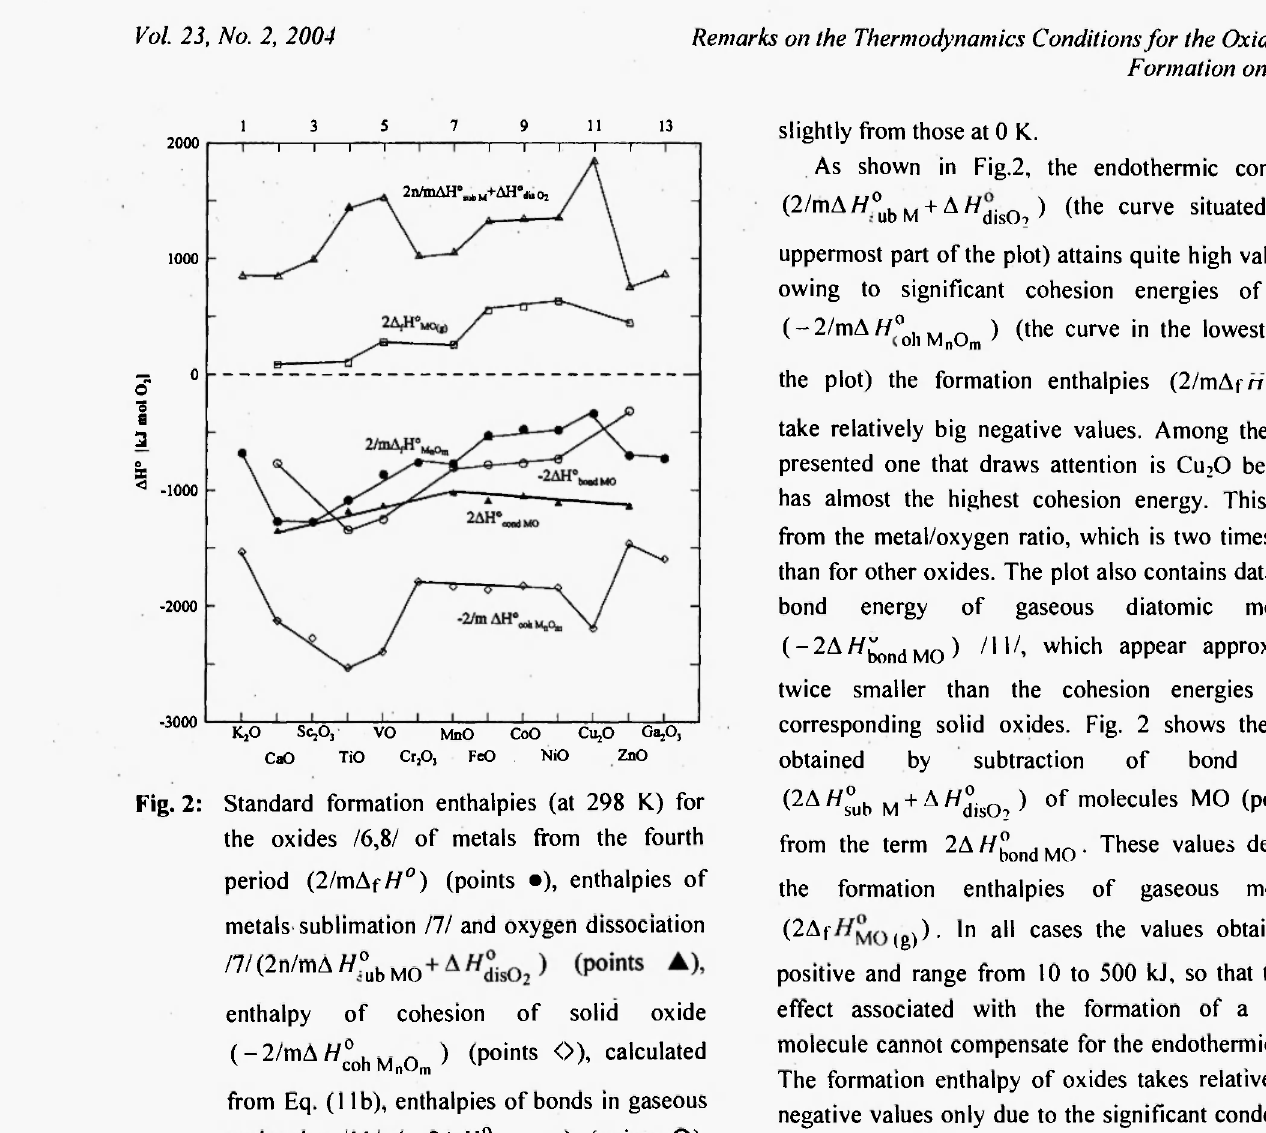
from Eq. (lib), enthalpies of bonds in gaseous